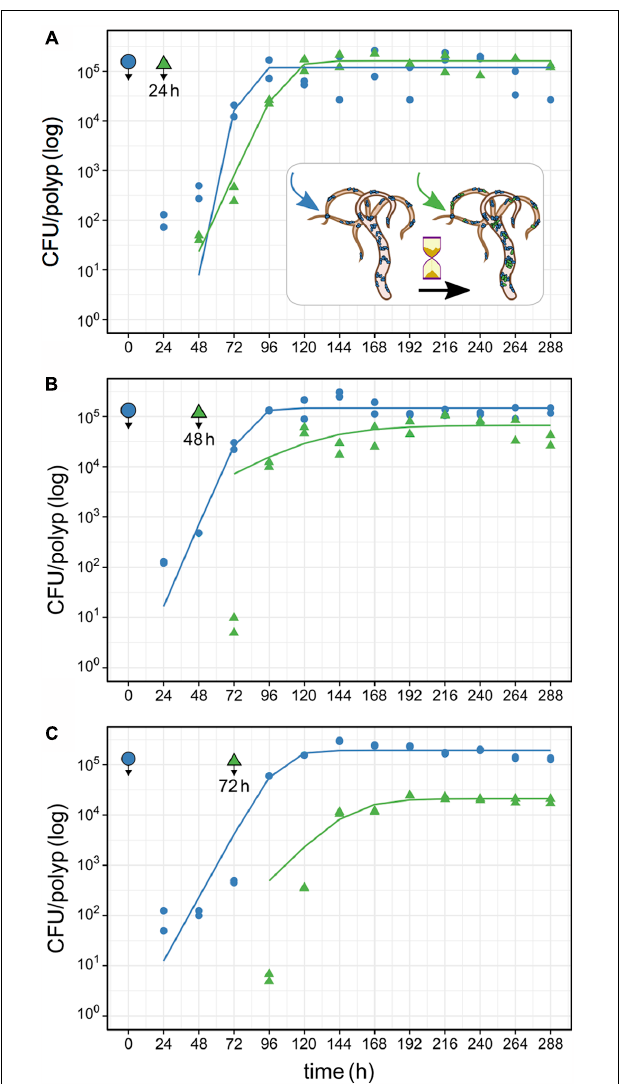
FIGURE 5 | Population size of primary and secondary Curvibacter colonizers on Hydra . After infection with the primary colonizer (blue, wild type), the second colonizer (green, pRL153-GFP) was added after a time lag of (A) 24 h, (B) 48 h or (C) 72 h. All experiments were conducted with two biological replicates. Solid lines represent the best fit of a logistic growth model.